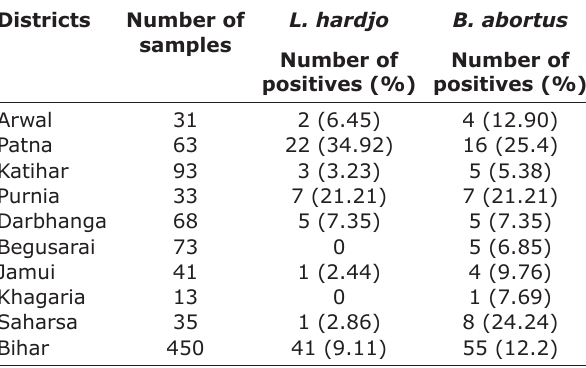
Table-1: District-wise seroprevalence of L. hardjo and B. abortus in Bihar.